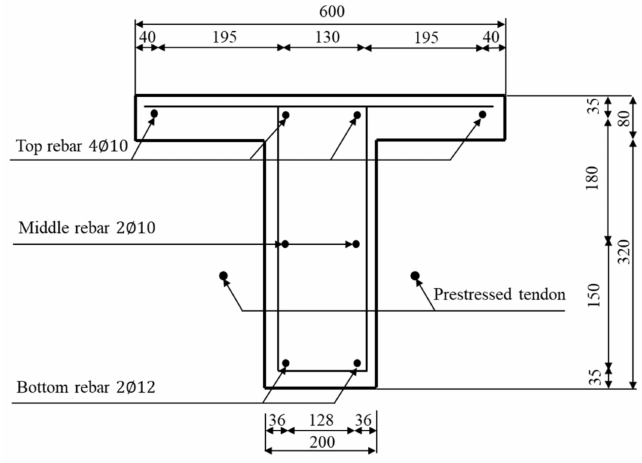
Figure 3. Tested precast prestressed concrete segmental beam.